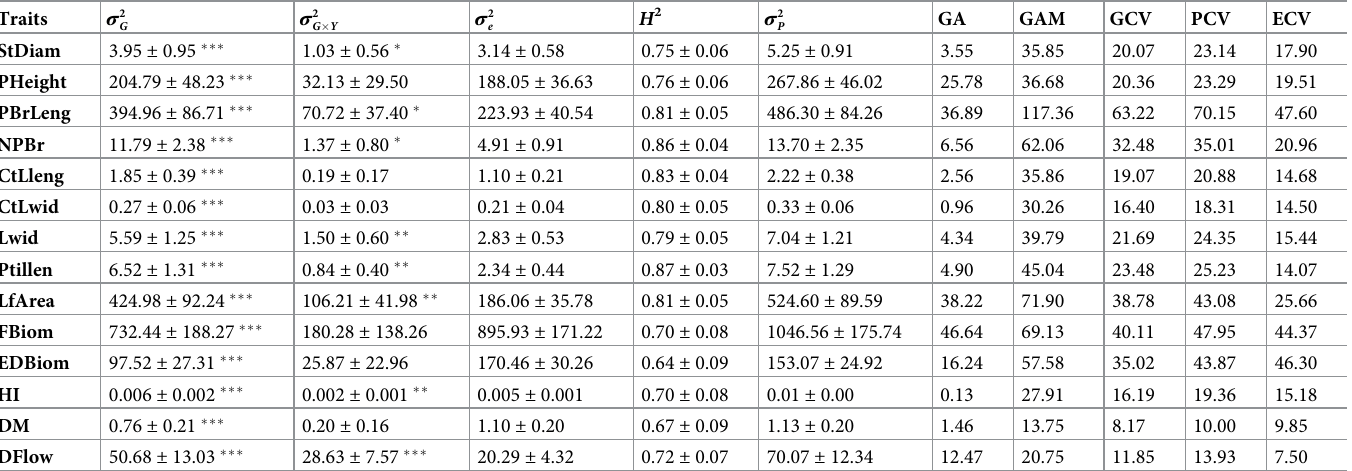
Table 4. Estimates of genetic parameters for biomass and related traits in 71 advanced lines of Gynandropsis gynandra evaluated over two years. Traits σ 2